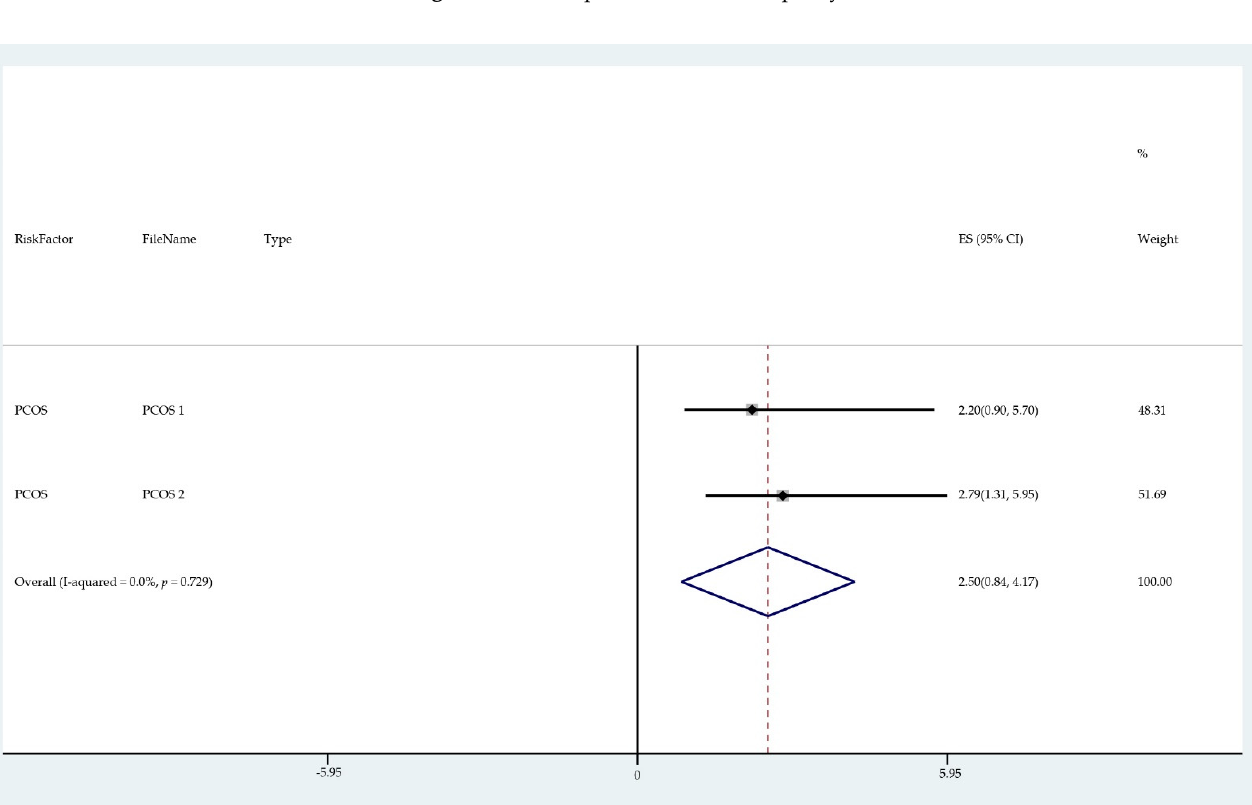
Figure 10. Forest plot to show risk of parity.